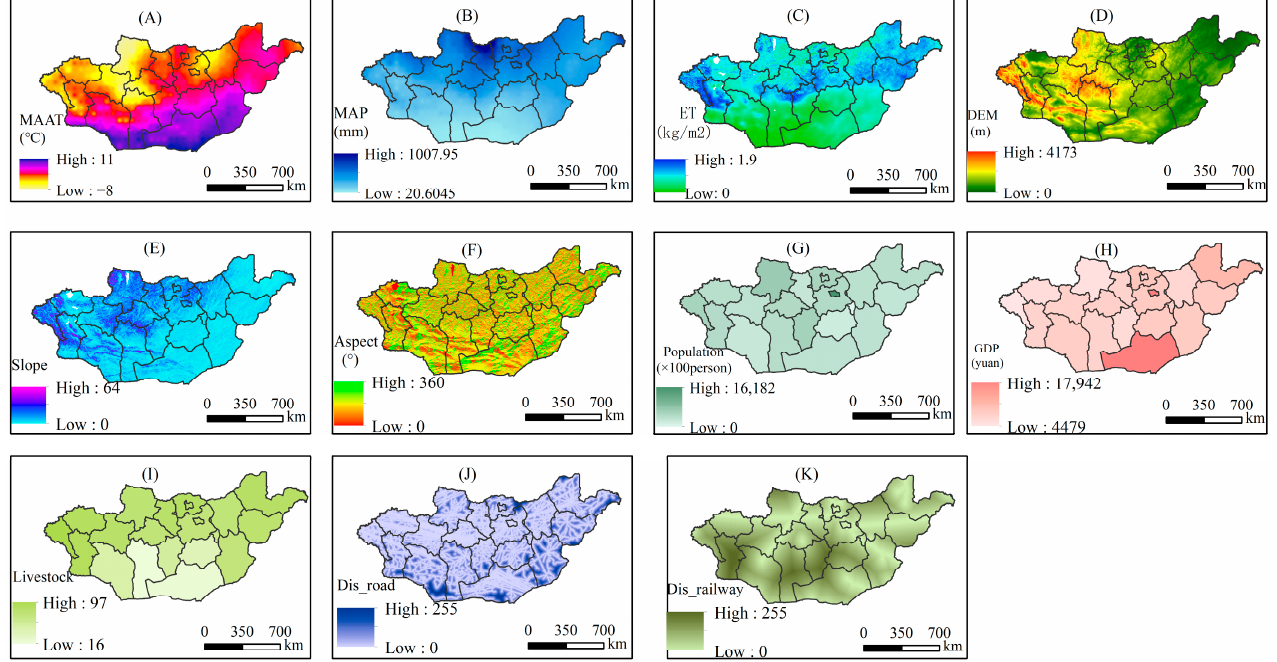
Figure 3. Spatial distribution of driving force variables for land use changes between 1990 and 2021 in Mongolia. ( A ) MAAT, ( B ) MAP, ( C ) ET, ( D ) DEM, ( E ) slope, ( F ) aspect, ( G ) population, ( H ) GDP, ( I ) Livestock, ( J ) distance to road, ( K ) distance to railway.